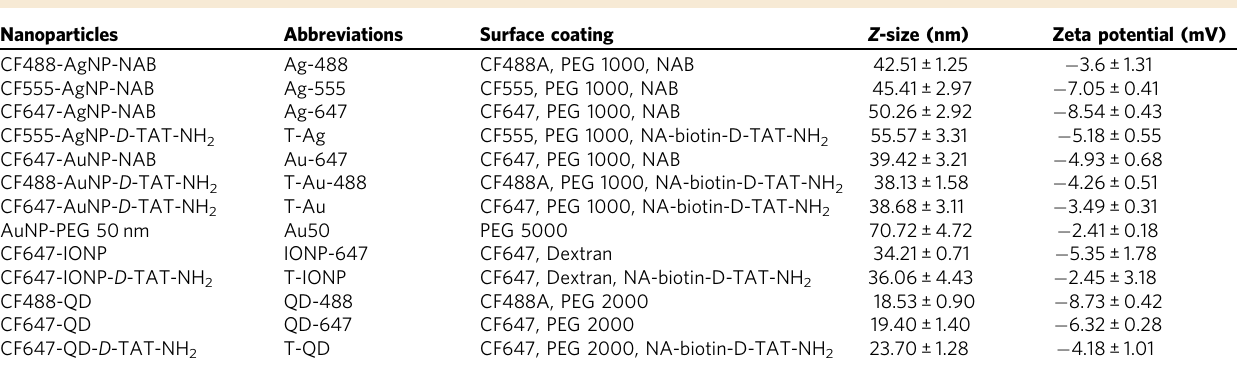
Table 1 Nanoparticles used in this study